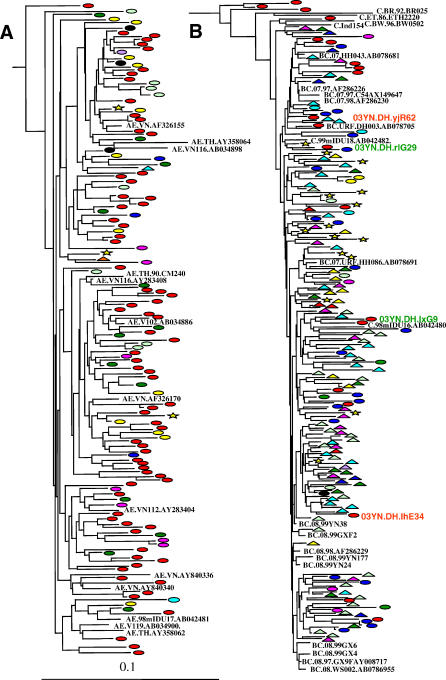
Continuation of the Phylogenetic Neighbor-Joining Tree Shown in Figure 2
Two clusters represent the two major circulating HIV-1 subtypes in Yunnan: CRF01_AE (A) and C/CRF07_BC/CRF08_BC (B).